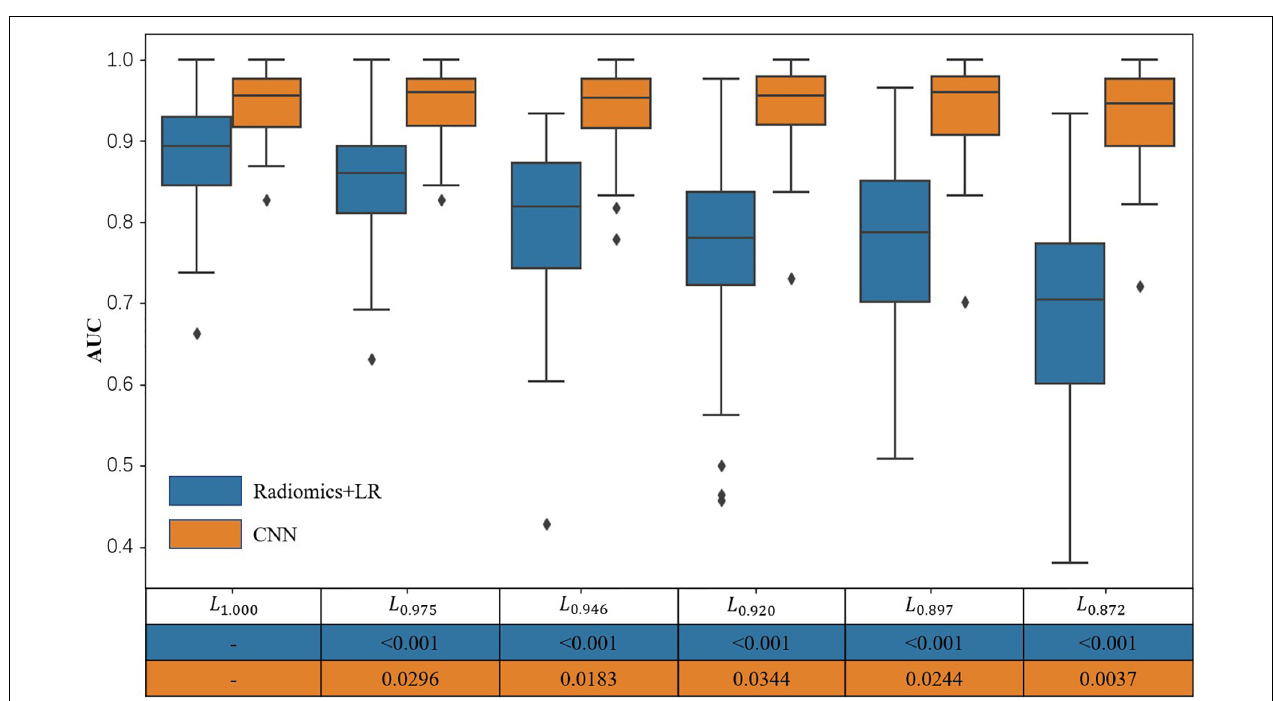
FIGURE 6 | Classification areas-under-curve of logistic regression and